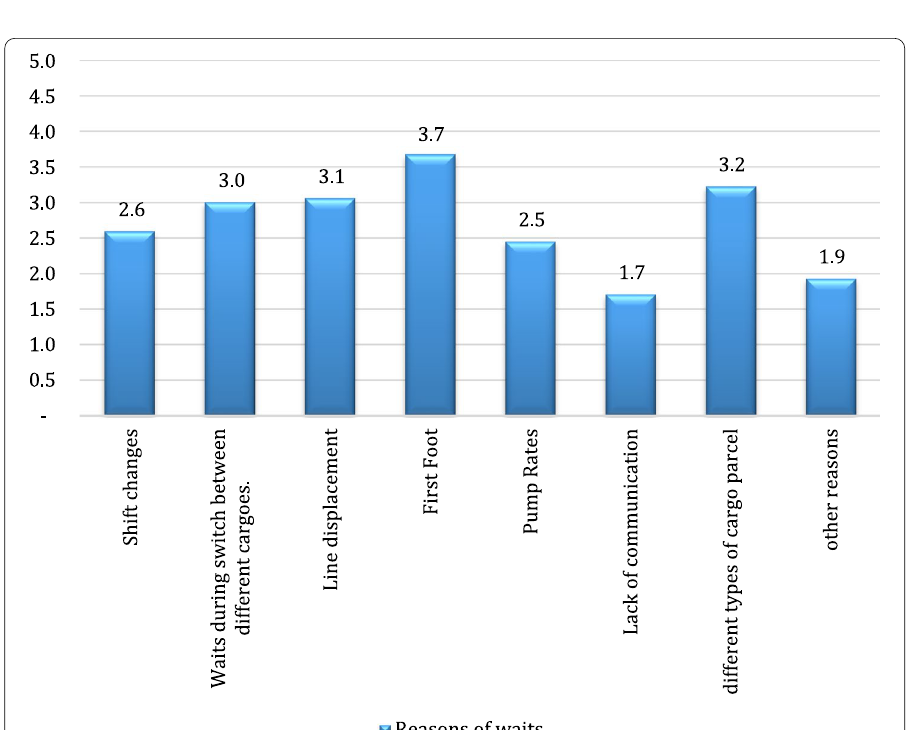
Fig. 4 Reasons for the waits during loading/unloading